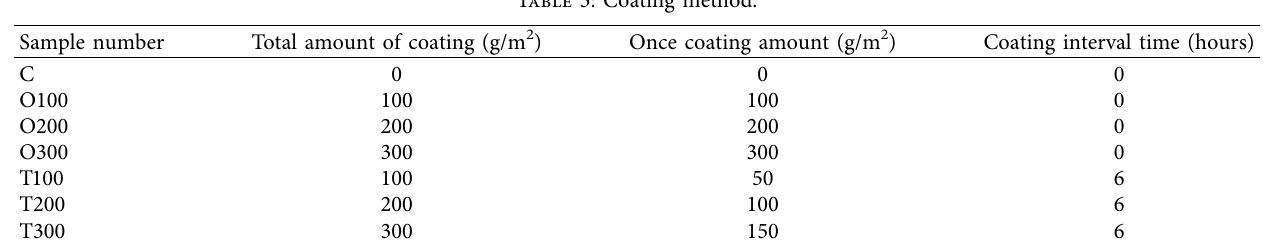
Table 3: Coating method.